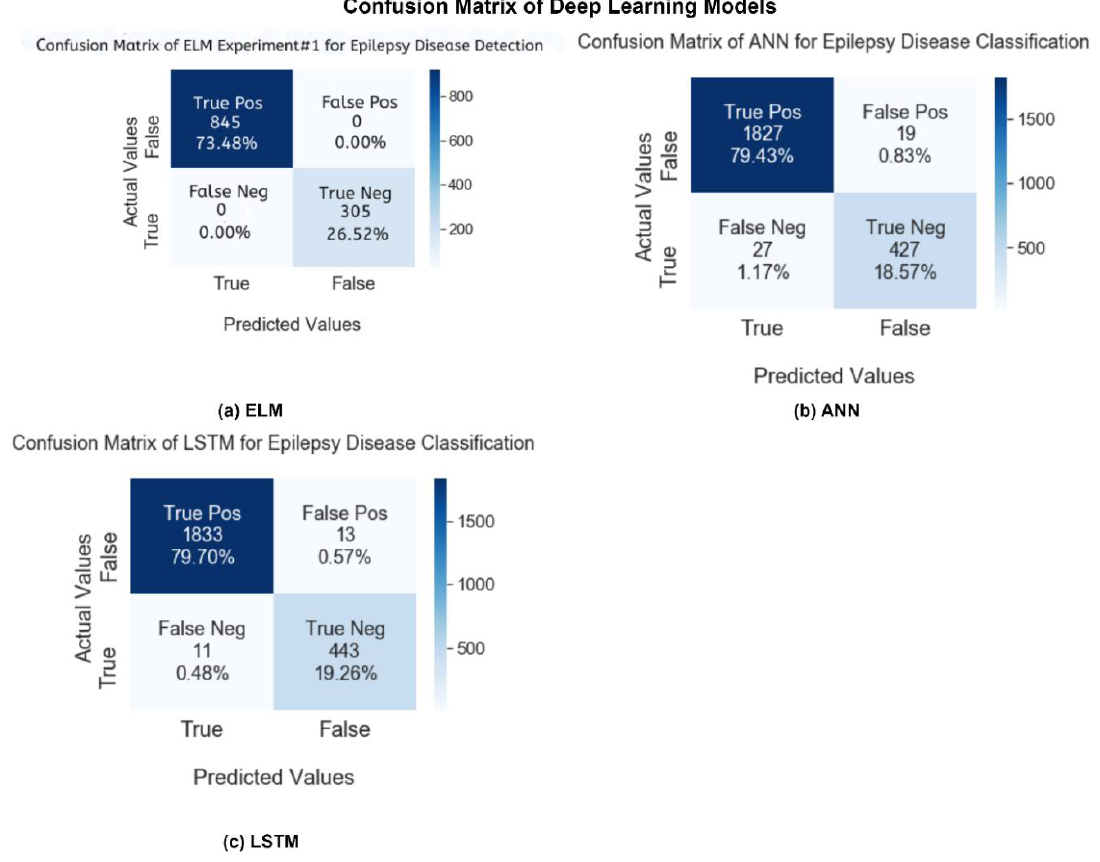
Figure 11. Confusion Matrices of ( a ) ELM #1; ( b ) ANN; ( c ) LSTM.